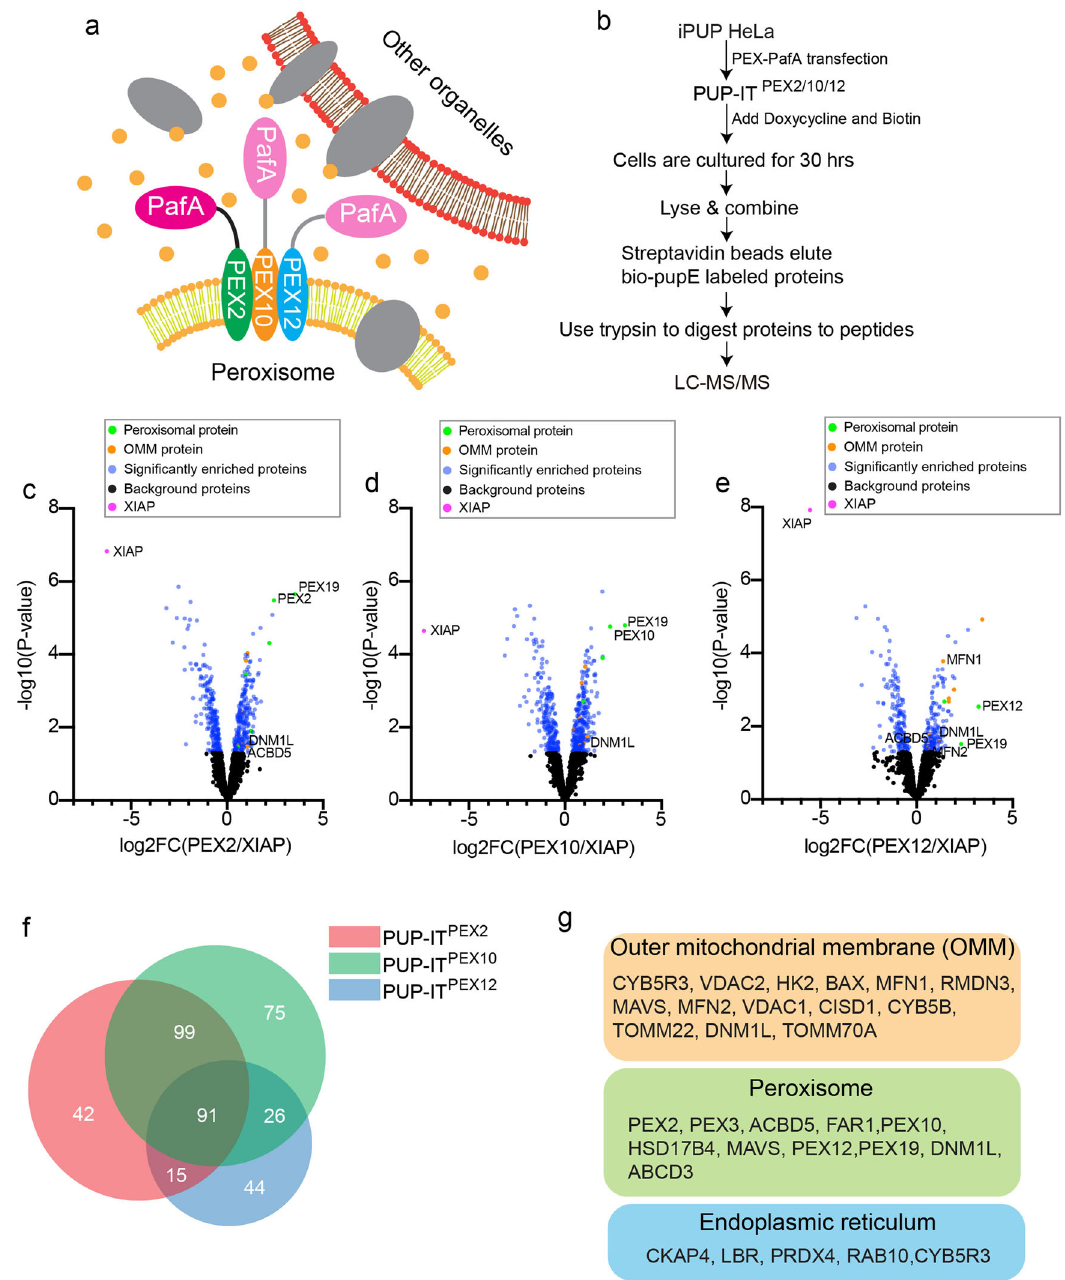
Fig. 1 Identi fi cation of PEX2/10/12 interacting proteins by PUP-IT. a Schematic view of the PUP-IT design to identify PEX2/10/12 proximity proteins. PafA was fused to one of the PEX proteins, co-expressed with bio-PupE (yellow dots), and mediates bio-PupE modi fi cations on proximal proteins. b The experimental work fl ow. The iPUP HeLa cells were transfected with PEX2-PafA, PEX10-PafA, and PEX12-PafA, respectively, to generate PUP-IT PEX2 , PUP- IT PEX10 , and PUP-IT PEX12 HeLa cells. The proximity labeling was induced in 2 × 10 7 cells by the addition of doxycycline (2 μ g/ml) and biotin (4 μ M) for 30 h. Cells were lysed, and bio-PupE modi fi ed proteins were enriched and identi fi ed by mass spectrometry. c – e Volcano plots of PUP-IT PEX2 , PUP-IT PEX10 , and PUP-IT PEX12 -interacting proteins. The logarithmic ratios of protein label-free quanti fi cation intensity (PEX/XIAP) were plotted against negative logarithmic P values in the limma package. Limma-based t-test was used for signi fi cant difference testing of data. The candidate proteins were determined by a moderated t-test ( P -value < 0.05) and fold change (fold change > 1.3). The blue dots represent signi fi cantly enriched proteins (false discovery rate ≤ 0.05; n = 3 independent experiments). The right arm comprises proteins that are proximal to peroxisomes, the left arm proteins proximal to XIAP. Yellow dots represent outer mitochondrial membrane (OMM) proteins. Green dots represent peroxisomal proteins. The magenta dot represents XIAP. f Analysis of signi fi cantly enriched proteins in three datasets (PUP-IT PEX2 , PUP-IT PEX10 , and PUP-IT PEX12 ) through Venn diagram. The data were analyzed with BioVenn 41 . g Subsets of proteins identi fi ed with proximity labeling include OMM proteins, peroxisomal proteins, and ER proteins. Other proteins are not shown but included in the Supplementary Data 1. Protein localization was assigned based on Uniprot and MitoCarta 3.0 42 .